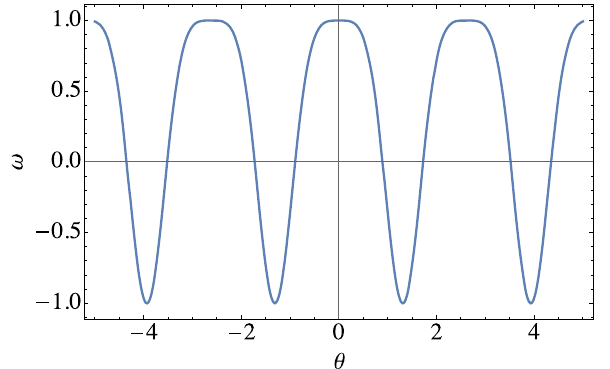
Fig. 1 Variation of Higgs field equation of state ω with periodicity θ for the local